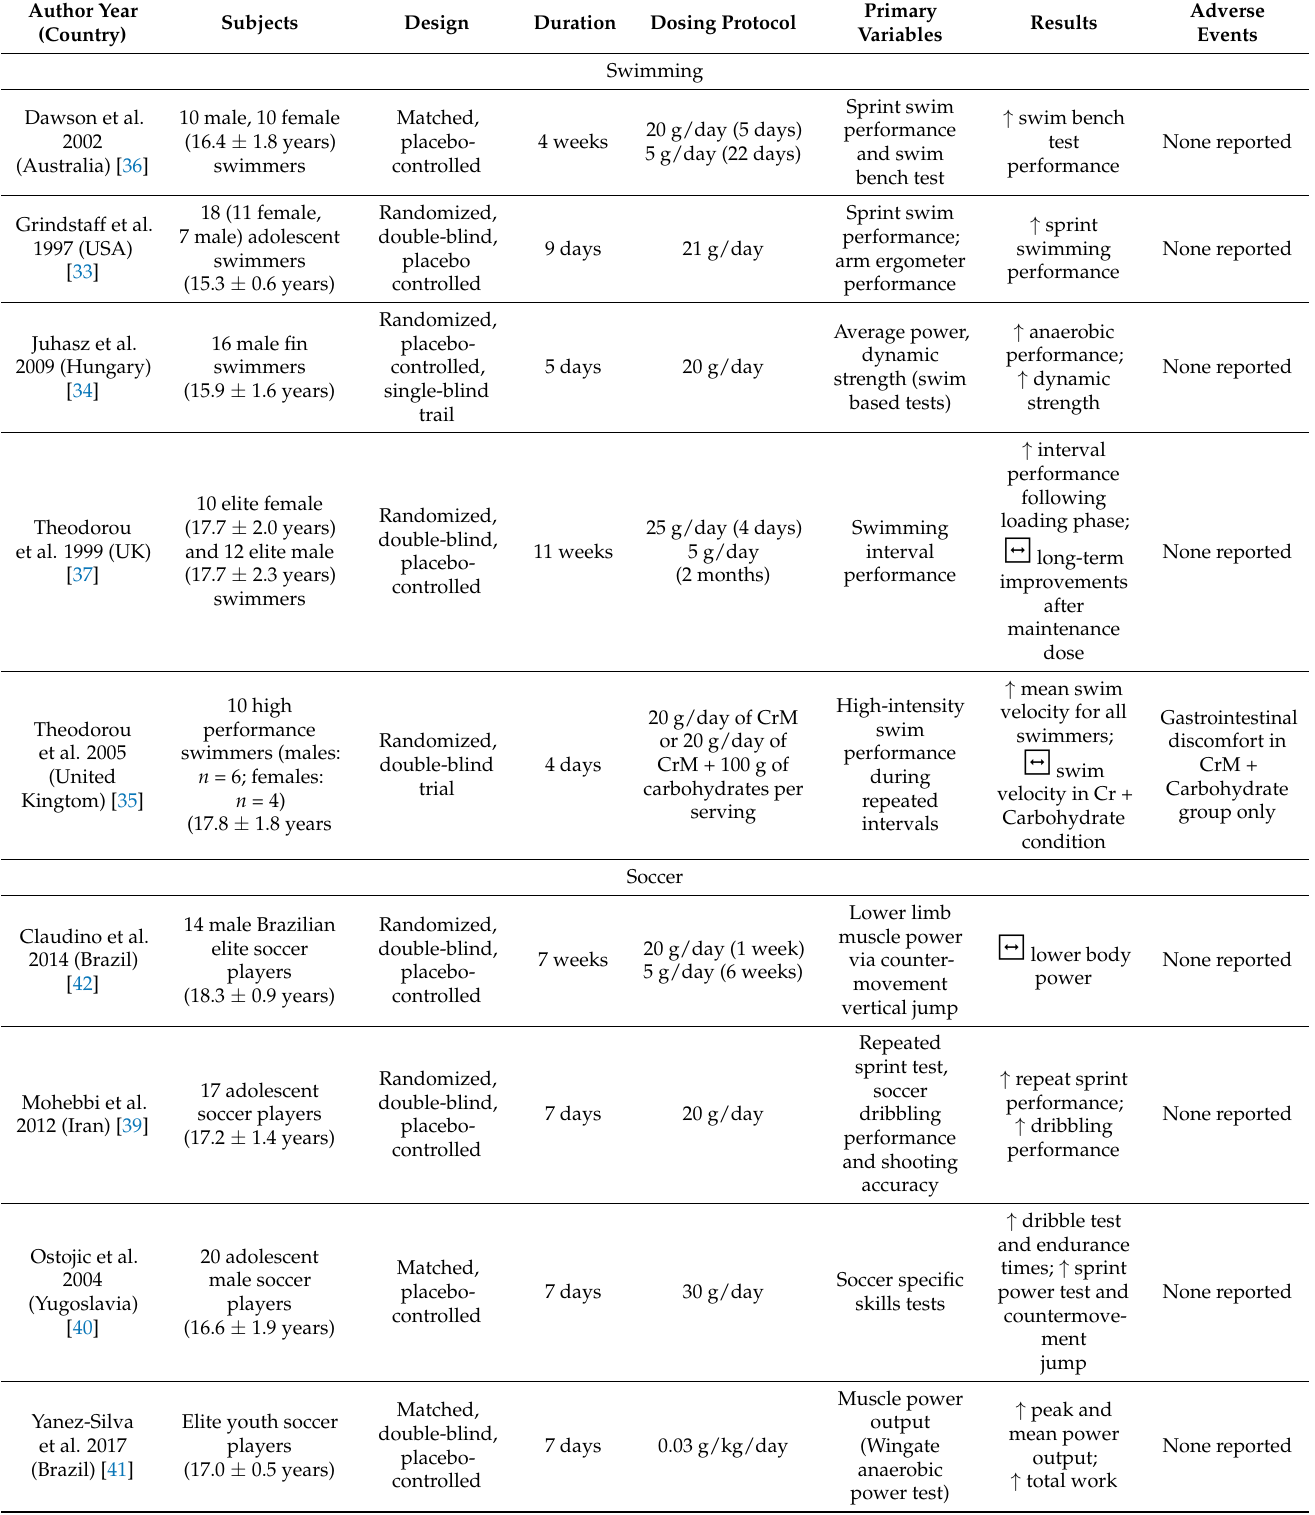
Table 1. Efficacy of creatine use in adolescents on exercise performance.